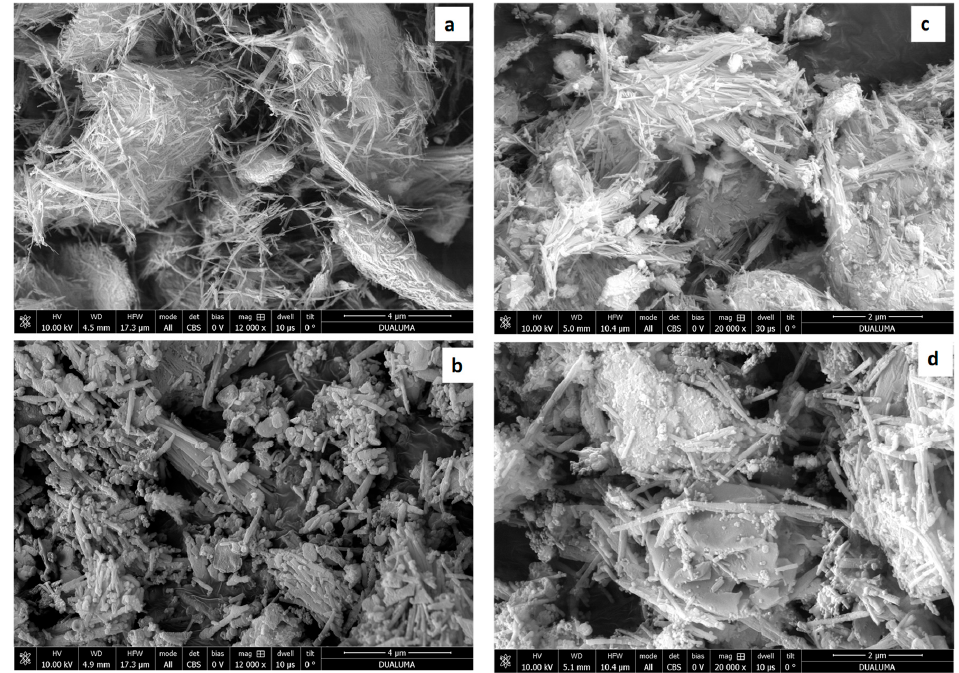
Figure 4. SEM micrographs of the starting sepiolite ( a ), sep-PCH ( b ), starting palygorskite ( c ) and pal-PCH ( d